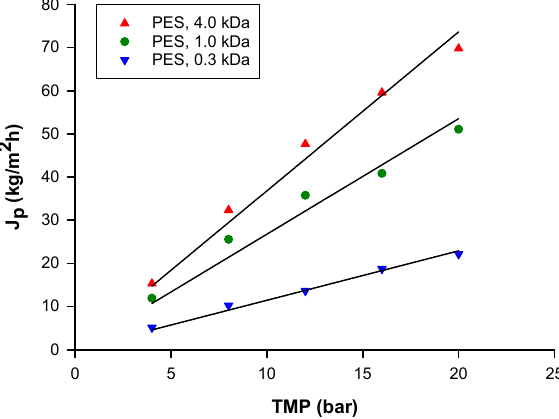
Figure 6. Effect of TMP on steady-state permeate flux for selected membranes (T: 26 ± 1 °C, Q f : 580 L/h).